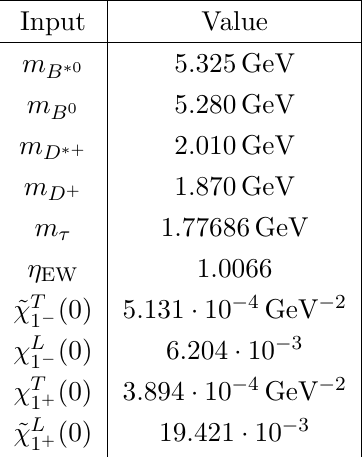
Table 4 . Additional numerical inputs. The calculation of the (cid:31) L;T (cid:31) L are needed for the scalar and pseudoscalar formfactors [13]; they are related to (cid:31) 1 +